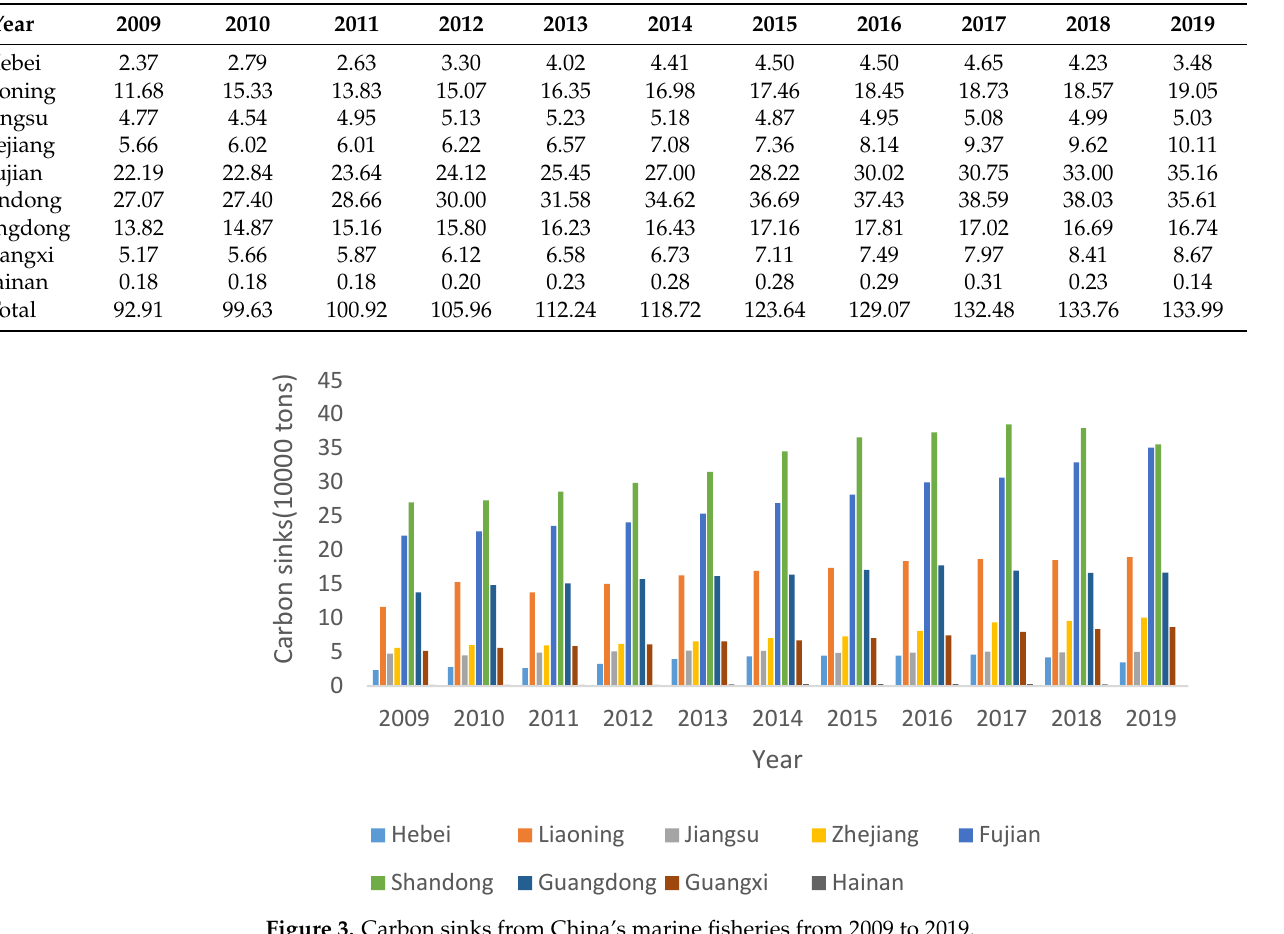
Table 6. Carbon sinks of marine fisheries in nine coastal provinces from 2009 to 2019 year (10,000 tons).